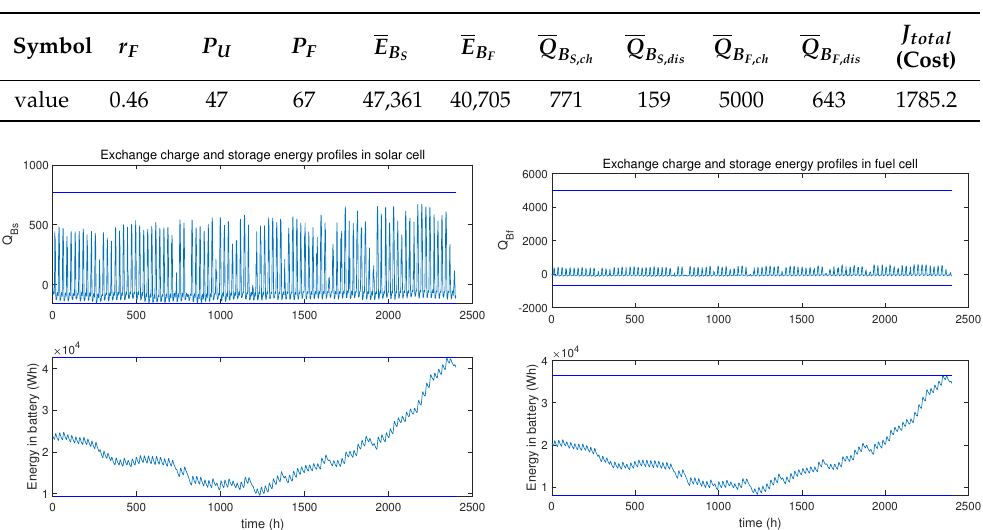
Table 3. List of element cost coefficients.